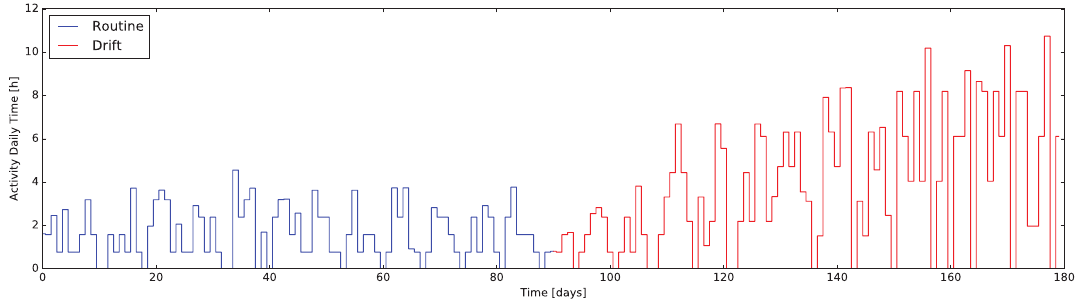
Figure 4. The “watching TV” Activity Daily Time (ADT) indicator: It is evident how the indicator tracks the behavioral change ad its value rises over 5 h in the drift-affected portion.